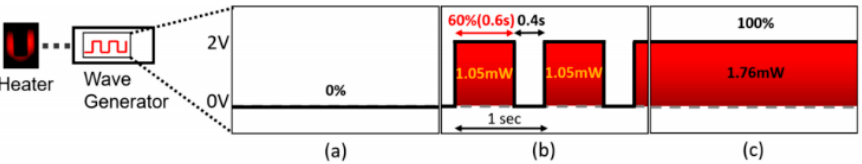
Figure 9. Schematic view of connection with microheater and power wave generator: ( a ) 0% duty cycle means non-heating; ( b ) 60% duty cycle of oscillation with 2 V shows 1.05 mW of energy consumption; and ( c ) full duty cycle (continuous heating) generates 1.76 mW of energy consumption [66].